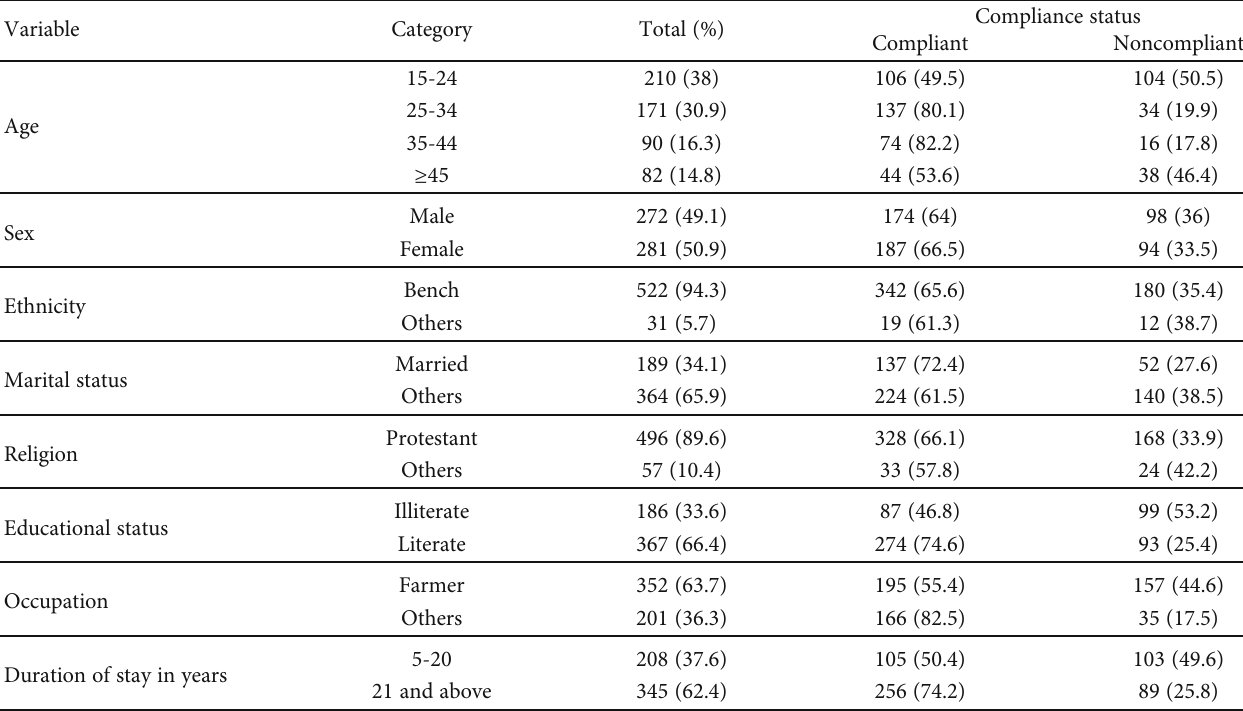
Table 1: Sociodemographic characteristics of study participants in Semen Bench District, Bench Maji Zone, Southwest Ethiopia, June 2018 ð n = 553 Þ . Variable